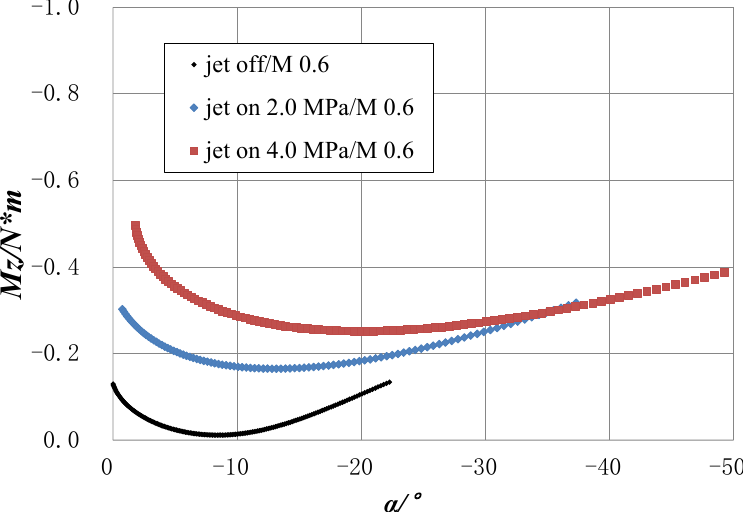
Figure 18. Moment curves of the revolution body for three jet conditions at M = 0.6.